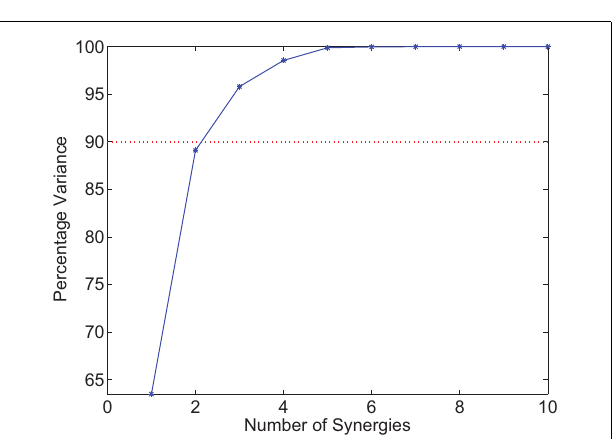
FIGURE 4 | This plot indicates how much of the data variability would be accounted for based on the number of synergies considered . Rule of thumb would indicate using three synergies, but since the controller is not solely dependent on the feedforward component less synergies can be